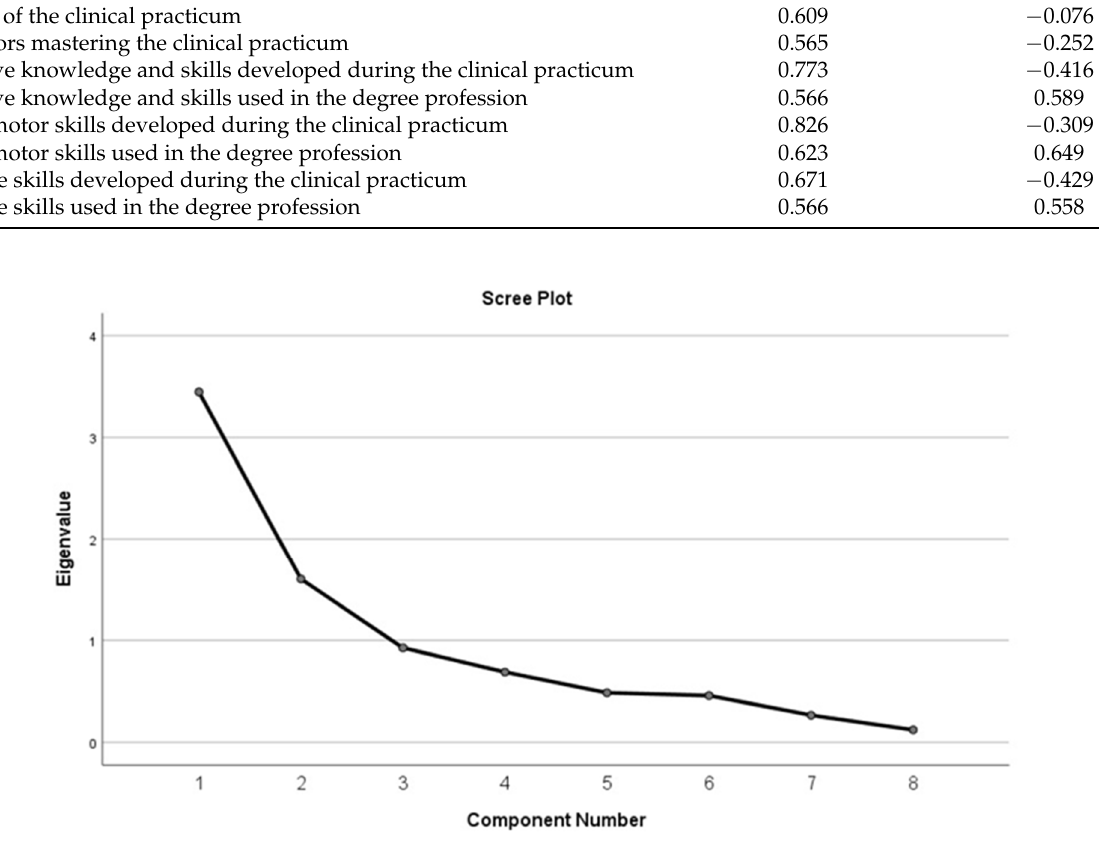
Figure 2. Scree plot for the principal component analysis (PCA) for the CPAT-QU construct validity. The descending tendency became weak from the third point.